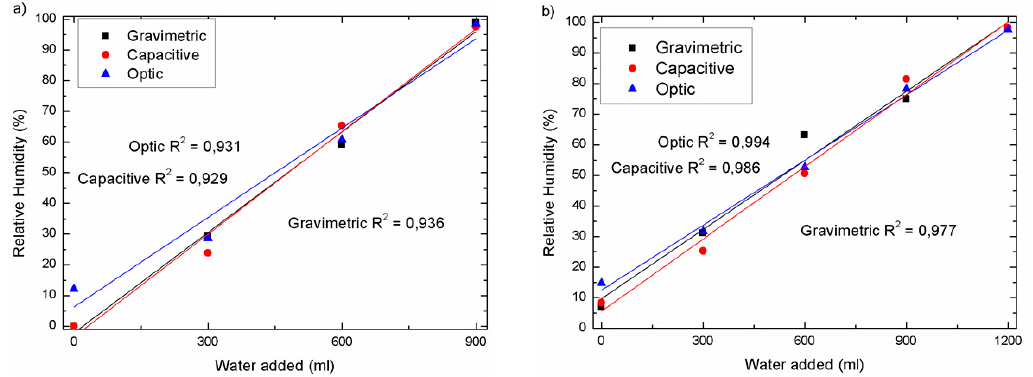
Figure 8. Capacitive and optical sensor’s response towards soil humidity: ( a ) Soil1 and ( b ) Soil2.